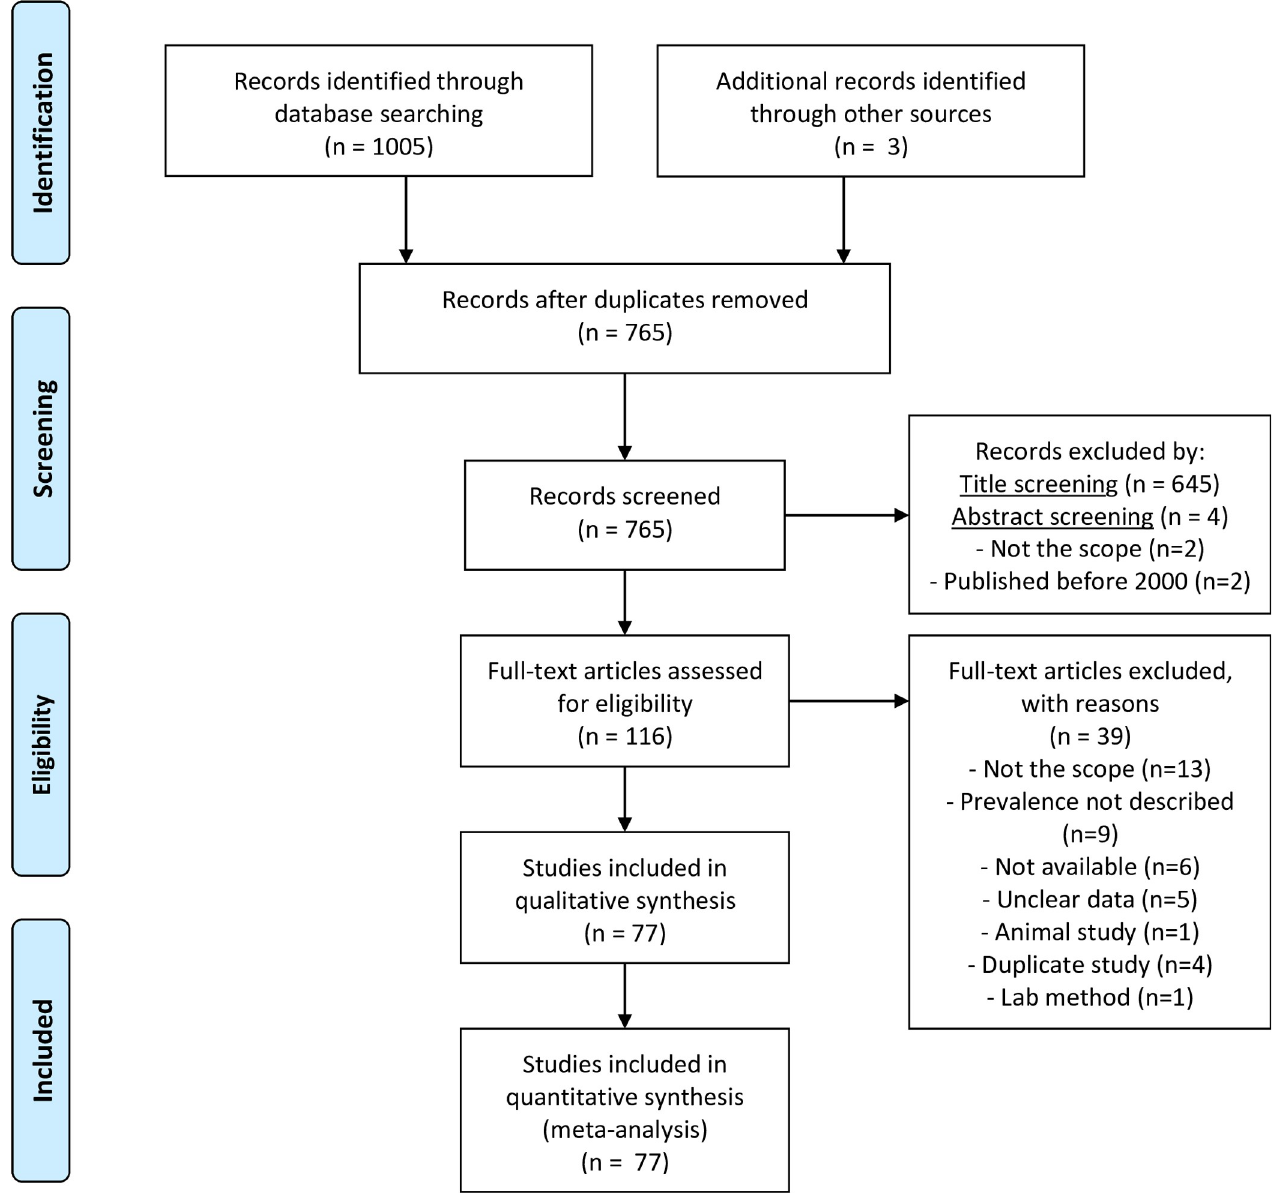
Fig 1. PRISMA flow diagram of study